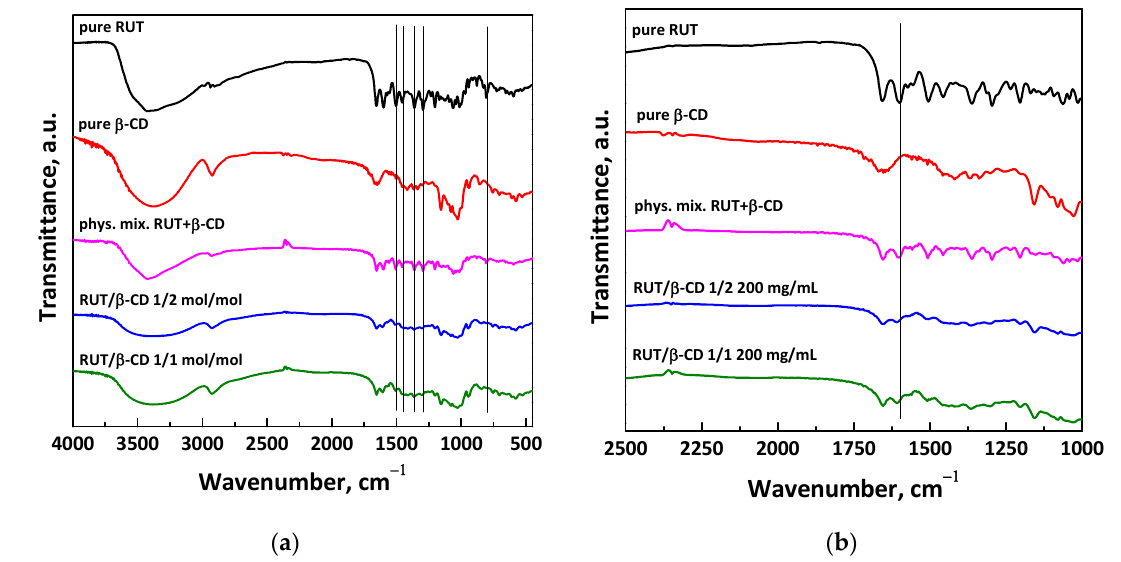
Figure 7. FT-IR spectra of unprocessed RUT and β -CD, physical mixture NSAID+ β -CD and SAS-processed RUT– β -CD powders at different molar ratios: ( a ) entire spectra; ( b ) enlargement of the spectra.